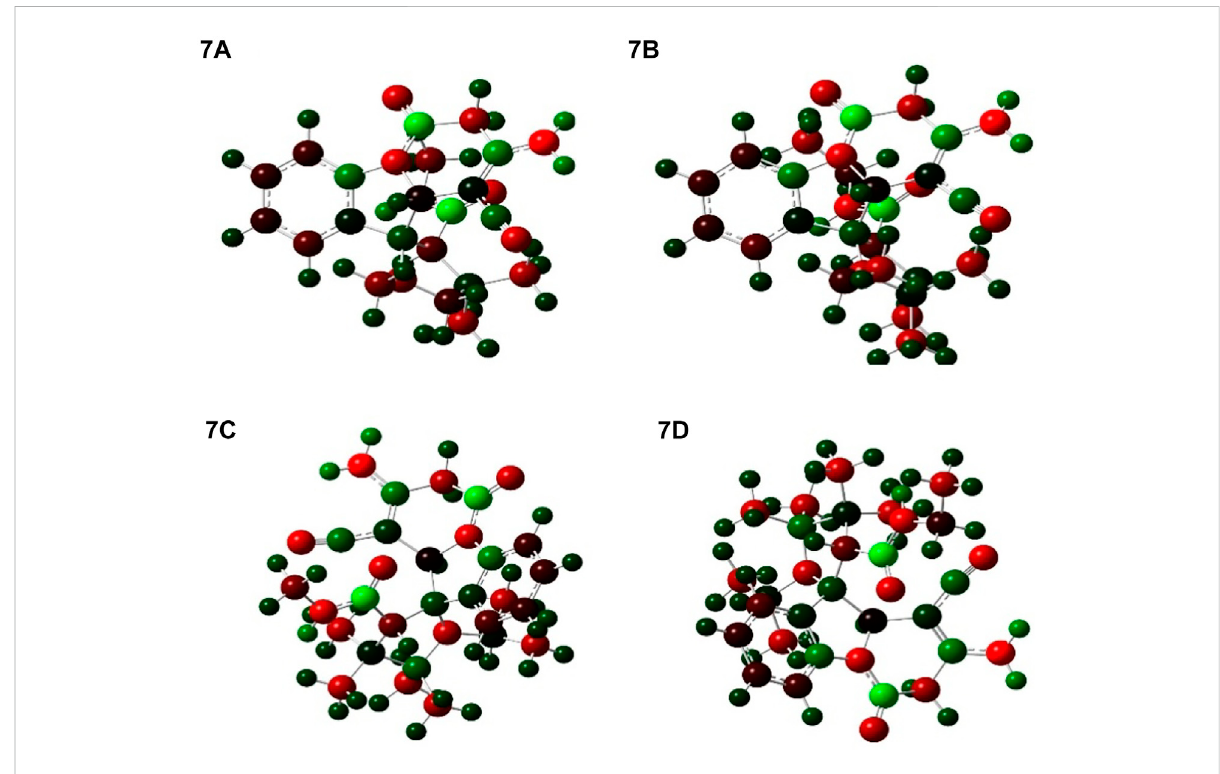
FIGURE 10 Distribution of Mulliken atomic charge for 7a-7d .